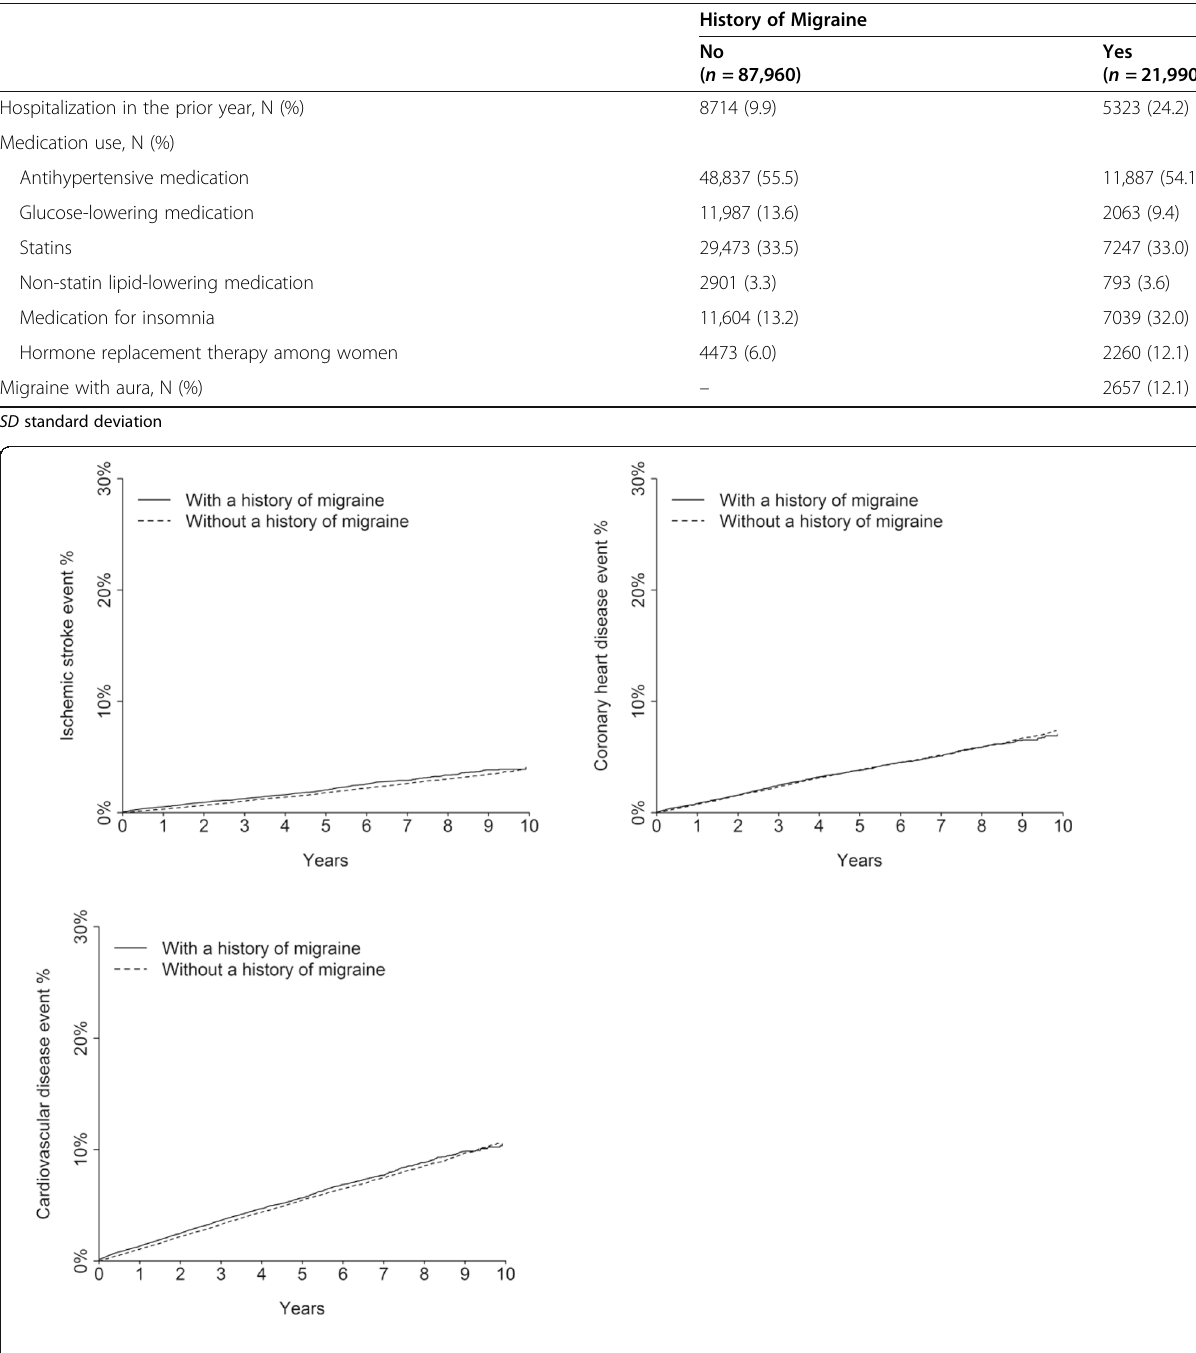
Fig. 2 Cumulative incidence ischemic stroke, coronary heart disease and cardiovascular events among patients with and without a history of migraine, restricted to those without a history of cardiovascular disease. CHD: coronary heart disease; CVD: cardiovascular disease. The cumulative incidence was calculated accounting for the competing risk of all-cause mortality using the method of Fine and Gray